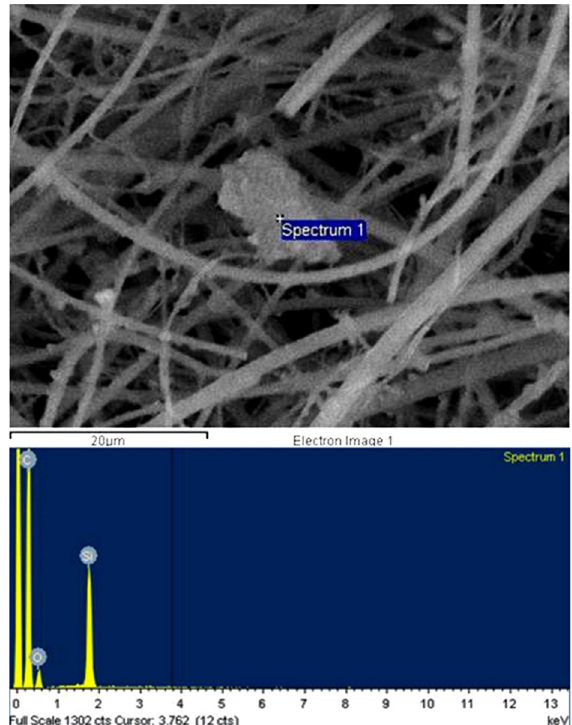
Figure 7. SEM micrograph and EDS spectrum of soot-dendritic particles.